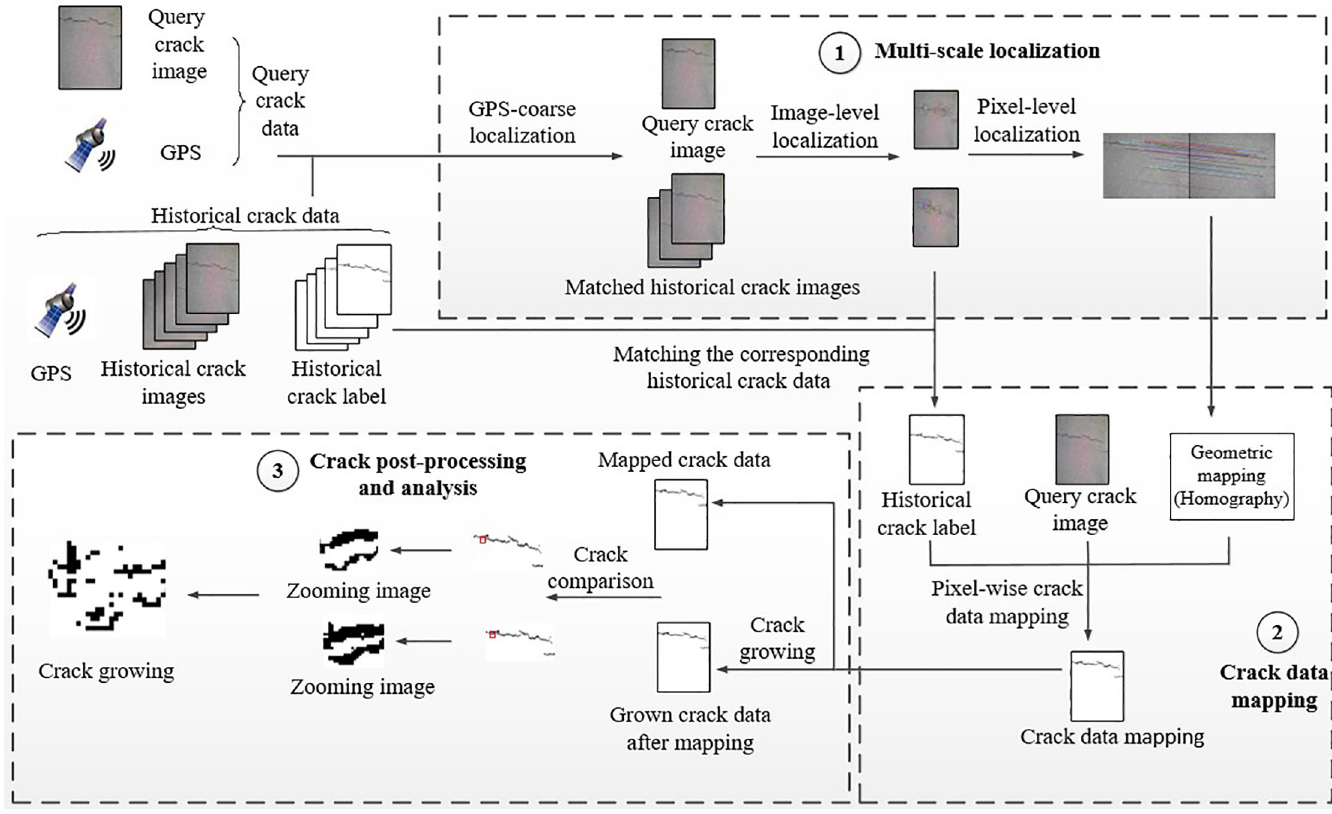
Fig 1. Illustration of the reference-based crack analysis